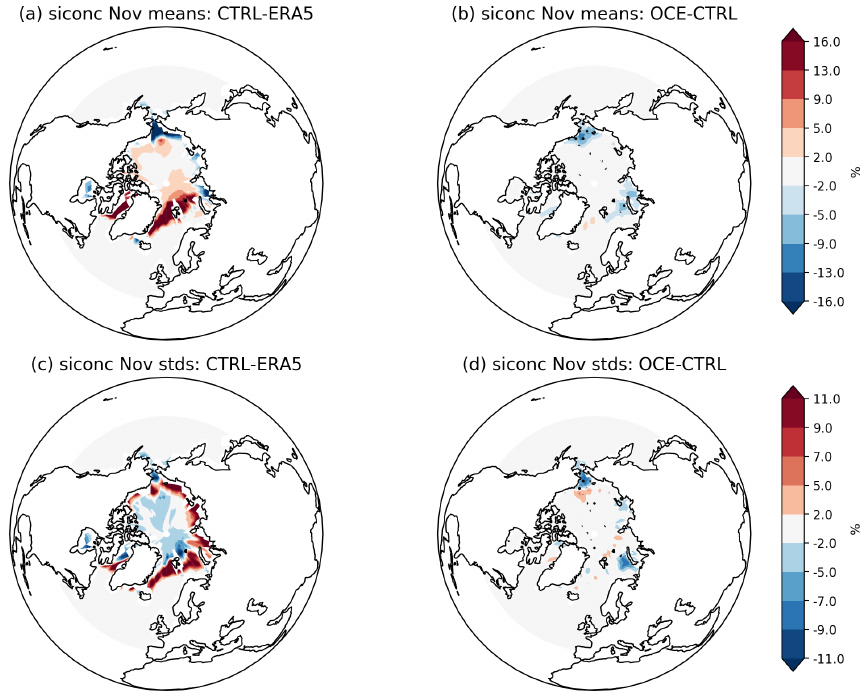
Figure 1. Sea ice concentration (mean and standard deviations) in November. Mean quantities in (a) CTRL − ERA5 and (b) OCE − CTRL. Standard deviations in (c) CTRL − ERA5 and (d) OCE − CTRL. Stippling in (b) and (d) highlights grid points where the change is statis- tically significant ( p < 0 . 05); in (a) and (c) almost every grid point outside the zero contour is significant, so stippling is not included for visual ease. The period considered is